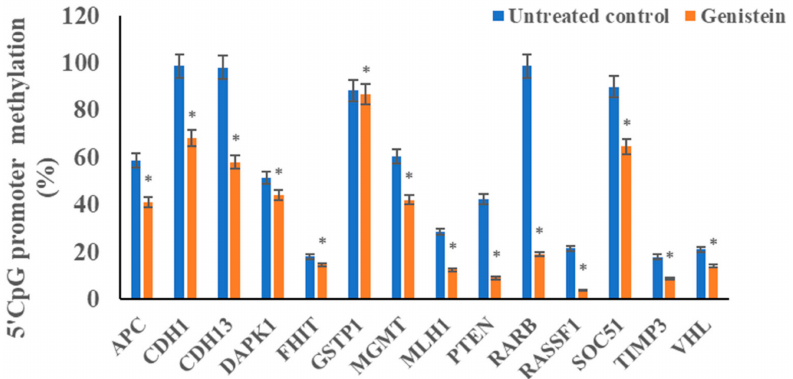
Figure 5. E ff ect of genistein on 5´ CpG island promoter methylation of tumour suppressor genes (TSGs) in HeLa cells using Human Tumor Suppressor Genes EpiTect Methyl II Signature PCR Array. Genistein (50 µ M) significantly decreased the promoter methylation levels in HeLa cells in comparison with the untreated control. The values are mean ± SD of three independent experiments (* p ≤